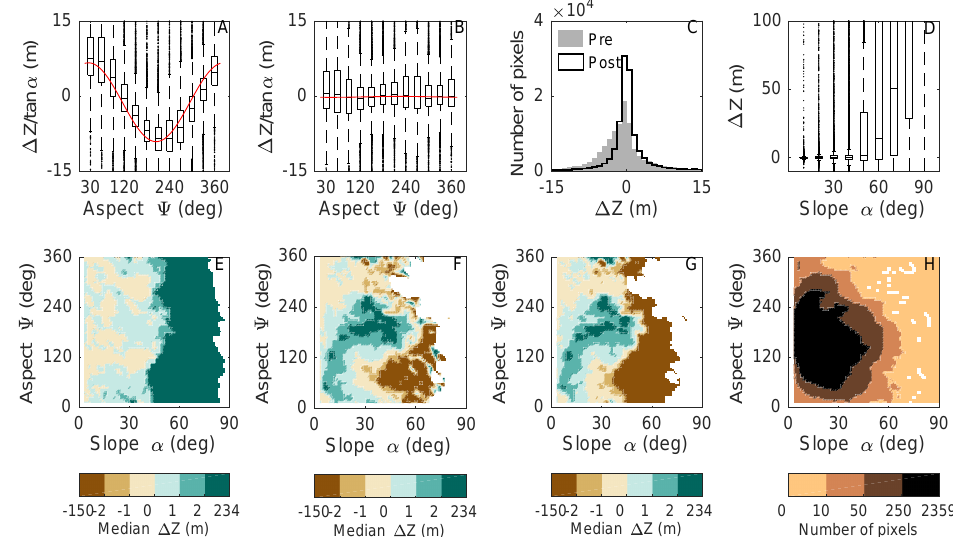
Figure 3. Results of data analysis and corrections of TanDEM12 relative to the ALS on SA ( A – E ) and applied to GA ( F – H ). ( A , B ): distribution of ∆ Ztan ( α ) vs. aspect Ψ before and after GC respectively; ( C ): ∆ Z histograms before and after GC; ( D ): variation of ∆ Z with slope of the surface. ( E – G ): heatmaps of median ∆ Z in slope-aspect ( α − Ψ ) domain binned in 1 ◦ α and 4 ◦ Ψ bins. ( E ): SA; ( F ): GA before slope/aspect correction; ( G ): GA after SAHC; The extreme values of the color scale correspond to maximum and minimum median ∆ Z across all three heatmaps. ( H ): 2D histogram of the slope and aspect distribution across the GA.